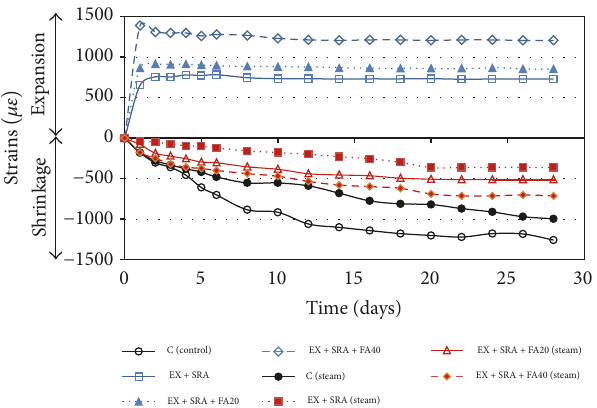
Figure 13: Total shrinkage results for EX + SRA and EX + SRA + FA (1 day after mixing).